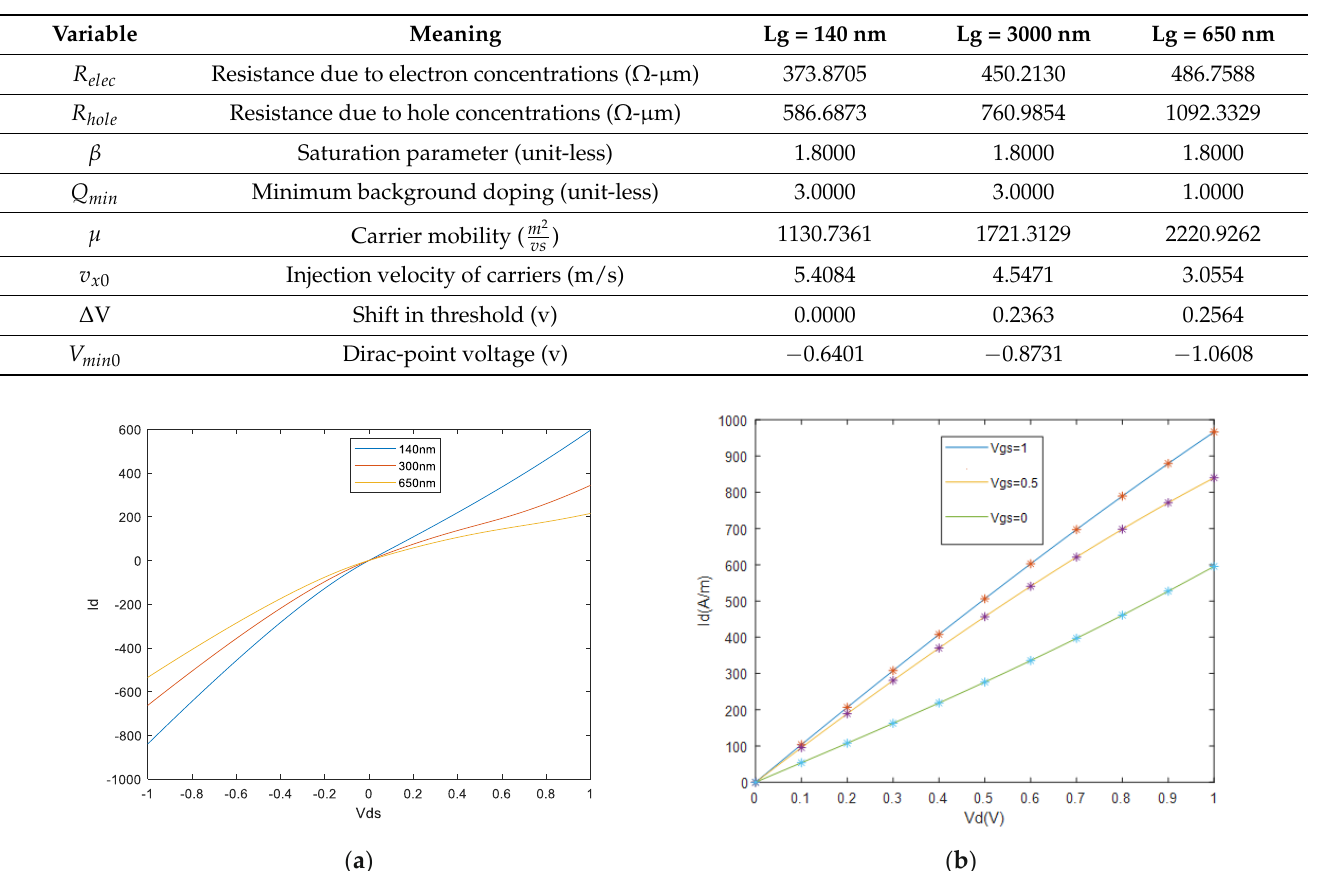
Figure 9. ( a ) Output characteristics of 140-300-650 nm device. ( b ) Output characteristics of 40 nm device. NEGF data are shown in symbols, while solid lines show the GFET model fits by AVS. Table 1. Fixed parameters in the AVS v1.0.0. model.